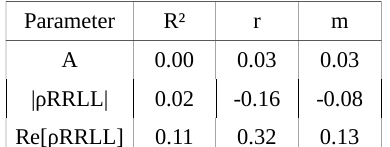
Table 2. Correlation parameters between roughness estimator and ks values for all data points.